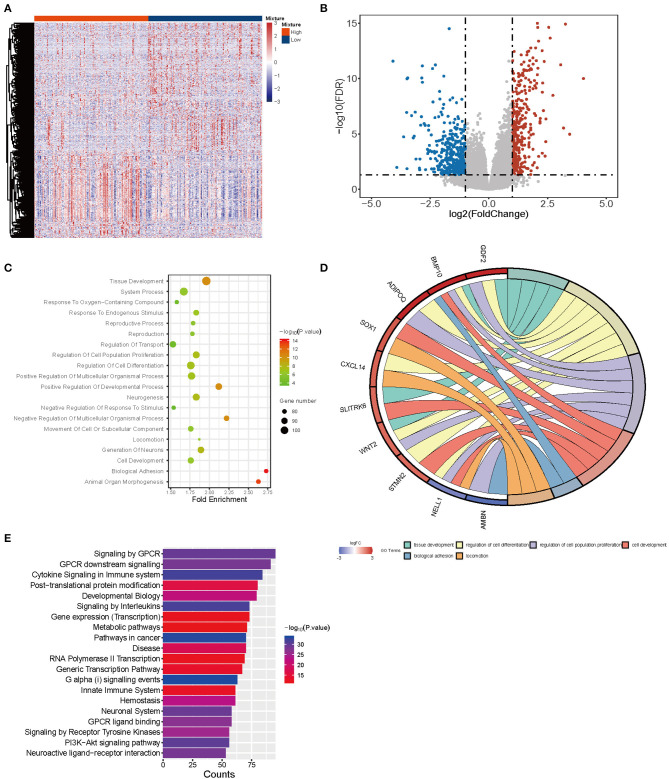
The differentially expressed genes between CD4-GZMA high and low groups defined by median proportion. (A) The heatmap of differentially expressed genes between CD4-GZMA high and low groups. (B) The volcano Plot of differentially expressed genes between CD4-GZMA high and low groups. (C) GO analysis of differentially expressed genes. (D) The chord diagram of GO analysis. (E) Pathway Enrichment of differentially expressed genes.